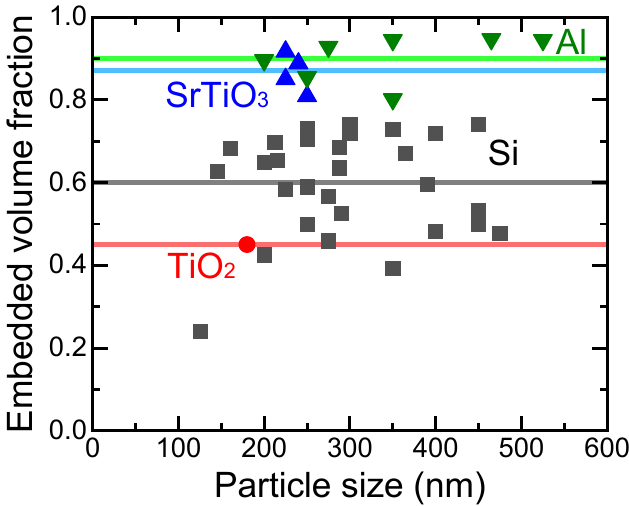
Figure 15. Particle size dependence of the embedded volume fraction for SMPs on various substrates of TiO 2 (red circle), Si (black squares), SrTiO 3 (blue triangles), and Al (green inverted triangles). The horizontal lines indicate the average values of the embedded volume fraction of particles with corresponding colors.